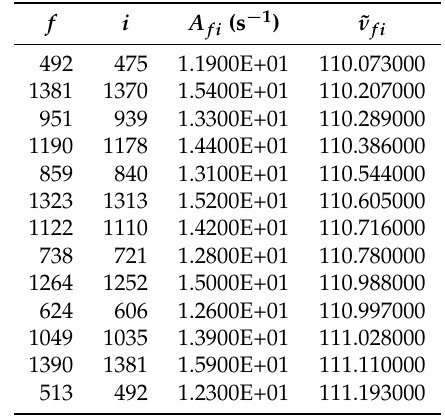
Table 2. Extract from the transitions file of the 7 Li 35 Cl line list.